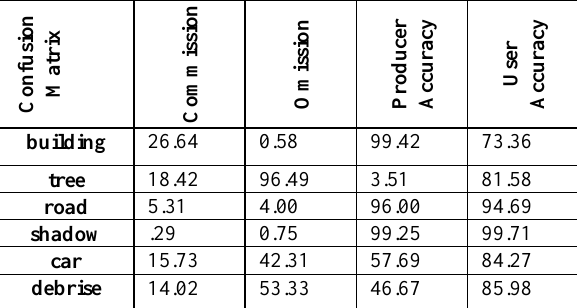
Table 2. Error matrix resulted from classification via SVM